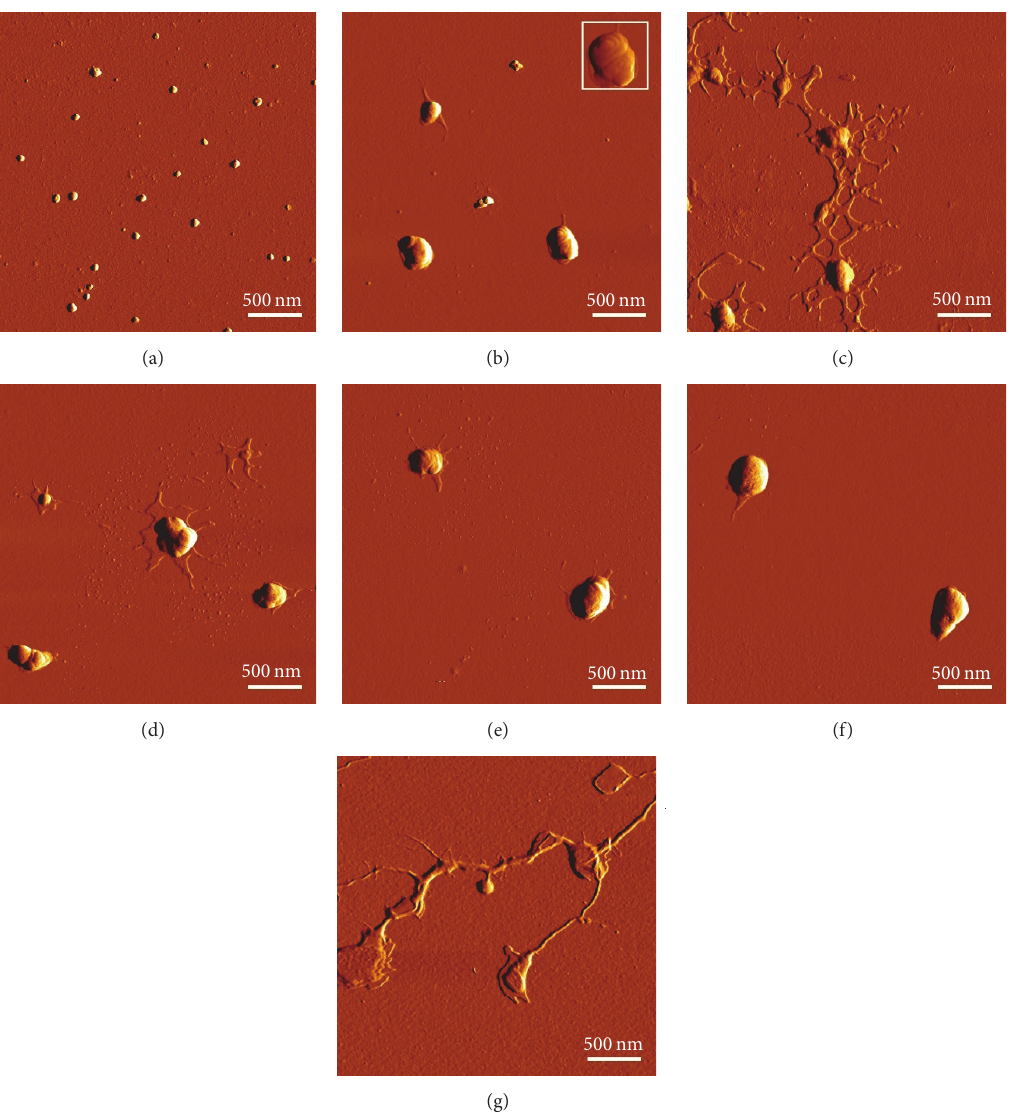
Figure 9: Visualisation of size and morphology of lipoplexes by atomic force microscopy. (a) 25kDa bPEI, (b) DOTAP, (c) hGDNT/DOTAP (5: 95), (d) PLFE/DOTAP (5 :95), (e) hGDNT/CH/DOTAP (5: 45 :50), (f) PLFE/CH/DOTAP (5:45 : 50), and (g) hGDNT/PC/CH/DOTAP (5: 30 : 35 : 30). All formulations were complexed at N/P 2.5–2.7. Inset: 500 × 500 nm.